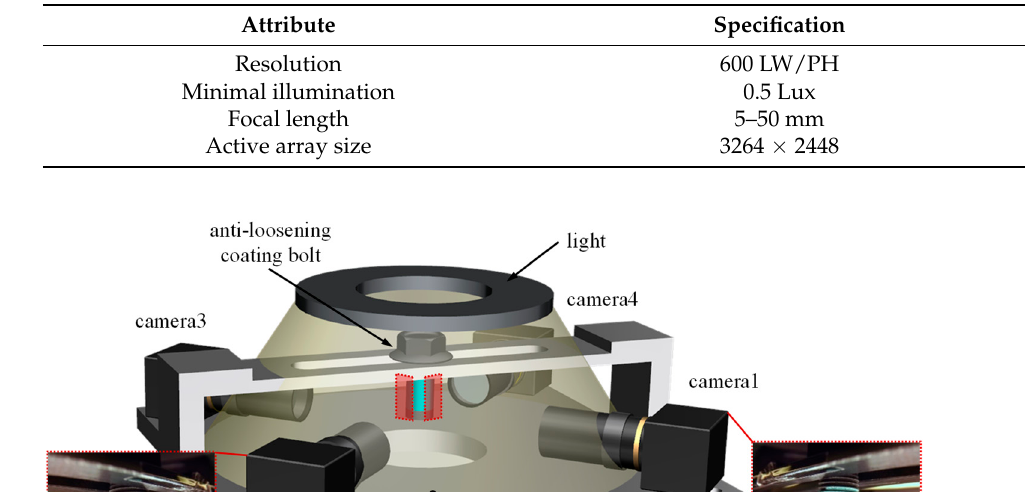
Table 1. Camera specifications.